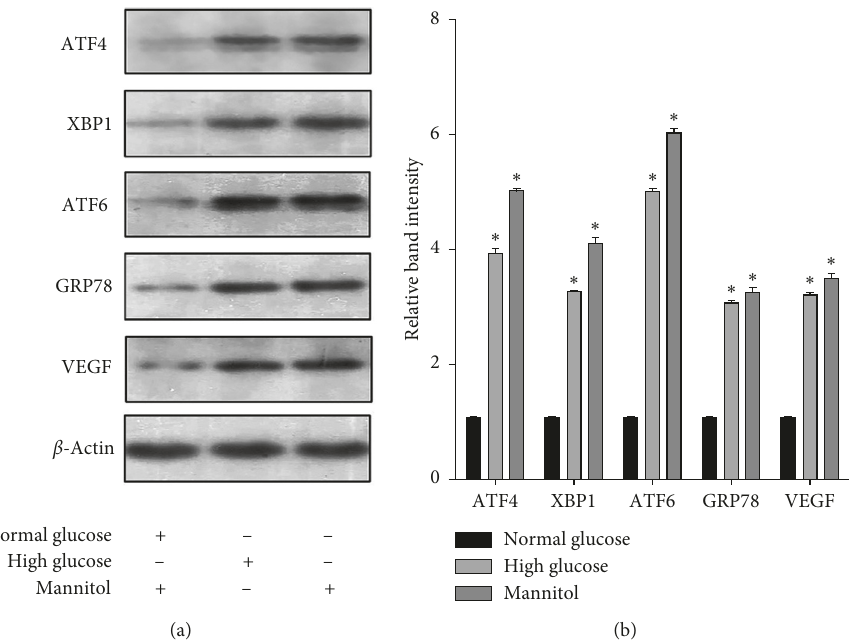
Figure 2: HG induced ER stress and increased expression of VEGF in rMCs. Expression of ER stress markers and VEGF in rMC-1 cells when exposed to normal glucose (5mmol/L), HG (30mmol/L), or glucose (5mmol/L) plus mannitol (25 mmol/L) for 48hours was determined by western blot analysis. The results were representative of 3 independent experiments ( n � 3; ∗ p < 0 .